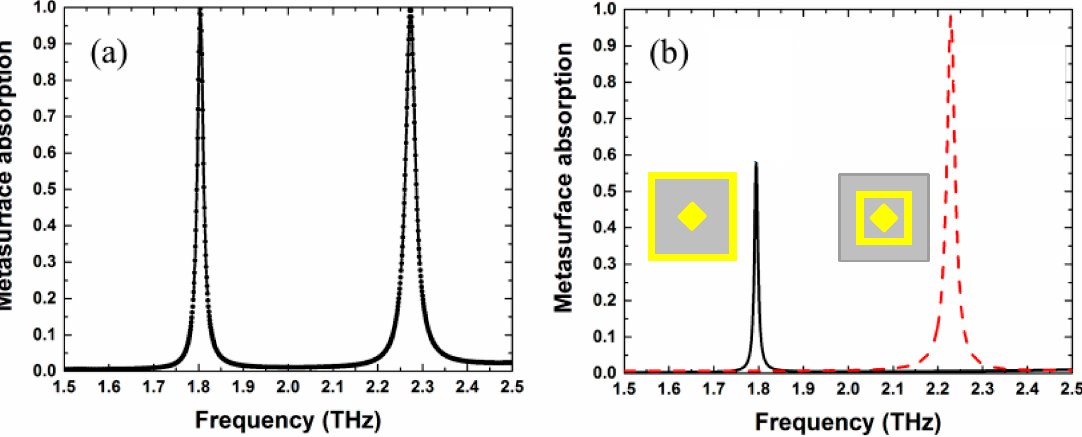
Figure 2. Panel ( a ): the polarisation insensitive spectral response of the dual-band absorber showing the two resonances at f 1 = 1.80 THz and f 2 = 2.27 THz. Panel ( b ): the e.m. response of the dual-band absorber in absence of the NA inner ring (black continuous line) or of the NA outer ring (red dot